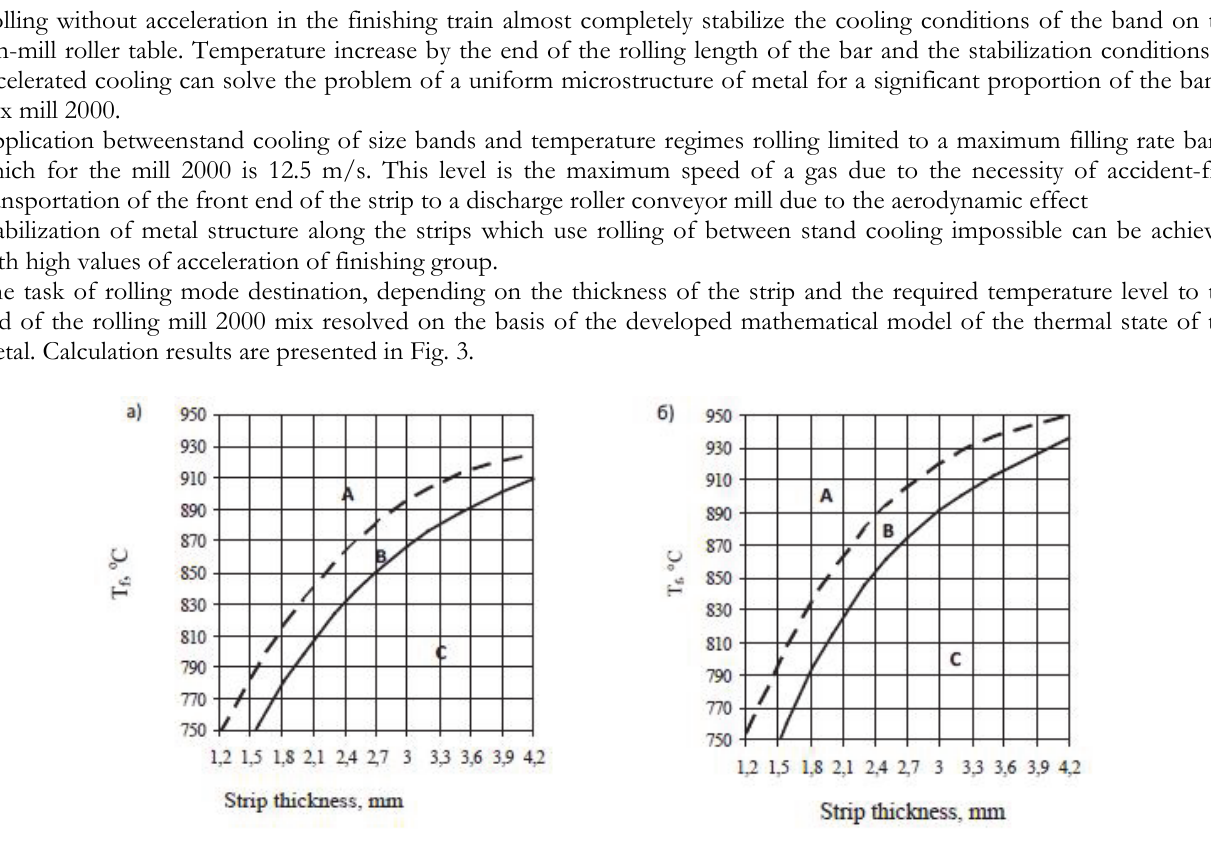
Figure 3: Assignment mode rolling strips in finishing group: a) tr = 1000°C; b) tr = 1030°C. (A - unreachable area, B - rolling with hither acceleration, C - rolling with QMKO =